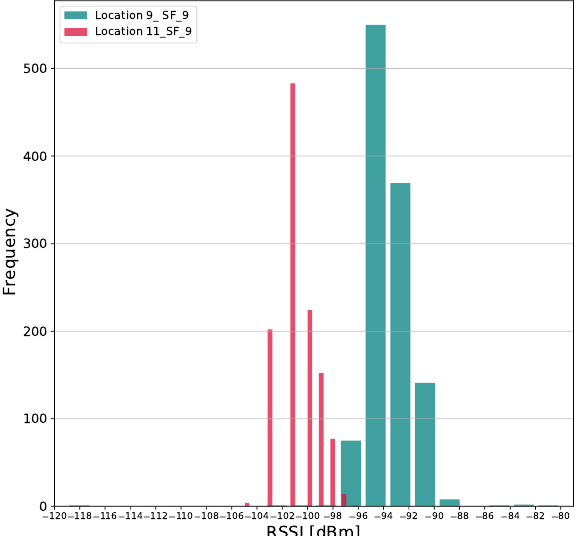
Figure 13. Histogram of RSSI values from gateway 5 for ROOM A509 for location points 9 and 11.